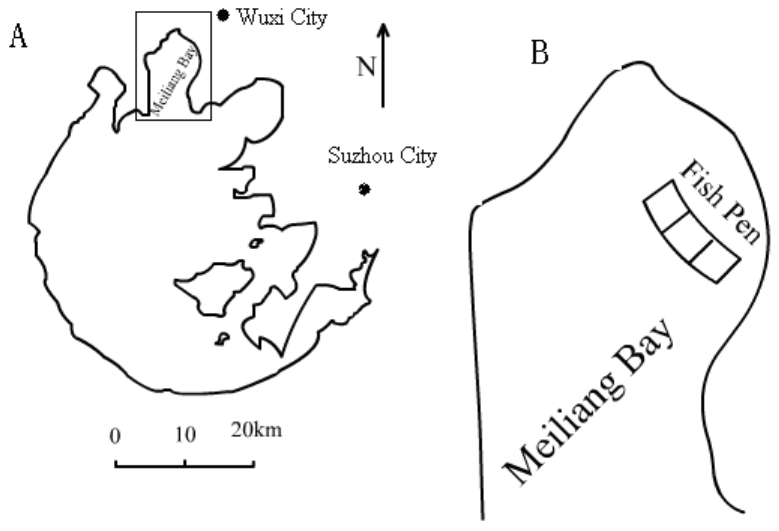
FIGURE 1. Sketch map of Taihu Lake (A) and the location of the fish pen in Meiliang Bay